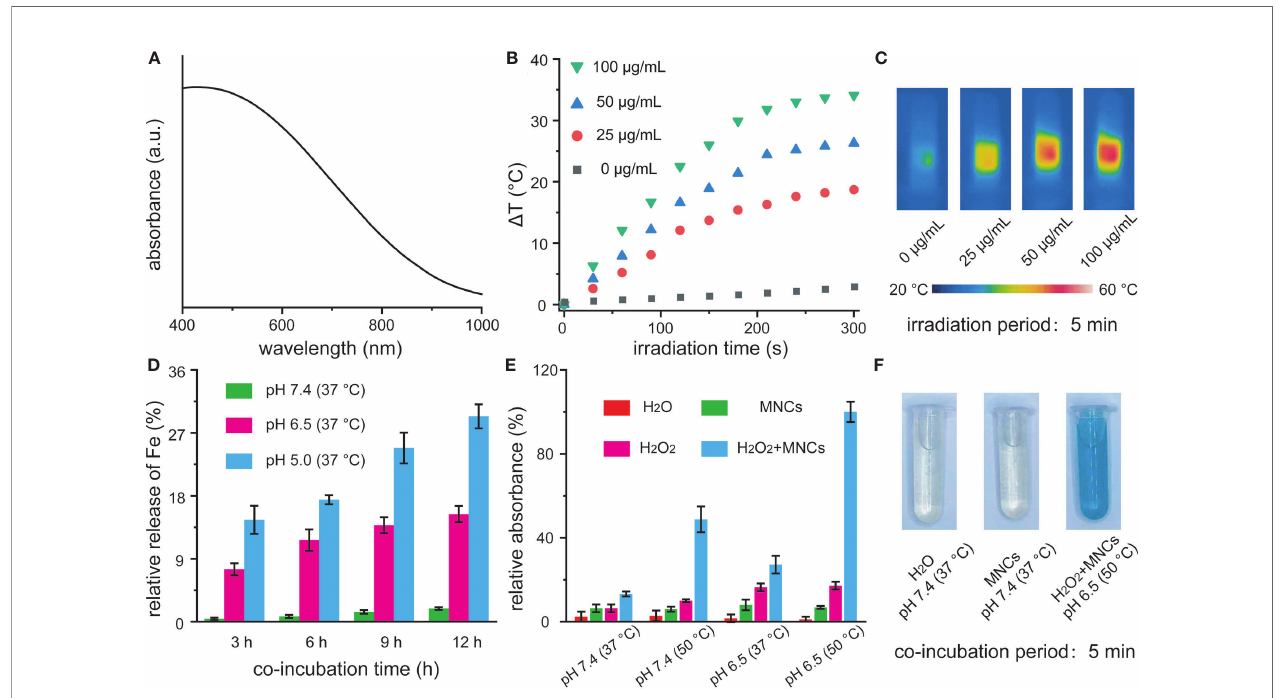
FIGURE 2 | UV-vis-NIR absorption spectra of MNCs in water (A) . Temperature change (B) and relative near-infrared photos (C) of MNCs under an 808-nm laser irradiation with a power intensity of 2 W/cm 2 . Time-dependent Fe release percentages from MNCs with a concentration of 1 mg/ml at different pH values (D) . Relative absorbance of TMB at 652 nm (E) and corresponding photos (F) after various treatments. The concentrations of MNCs, TMB, and H 2 O 2 used in (E, F) were 50 m g/ml, 1 mM, and 20 mM,